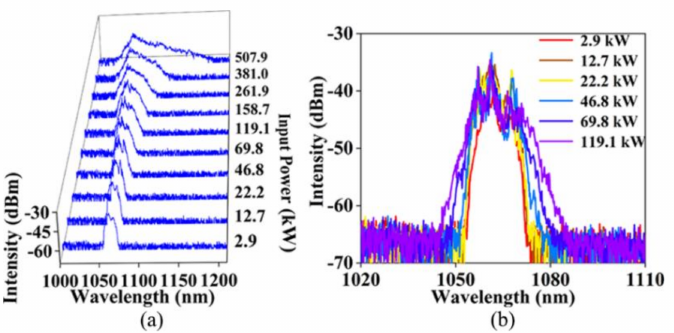
Figure 5. ( a ) Measured output spectra from the MMF with a 3.6 cm tapered length versus input peak powers; ( b ) the first six